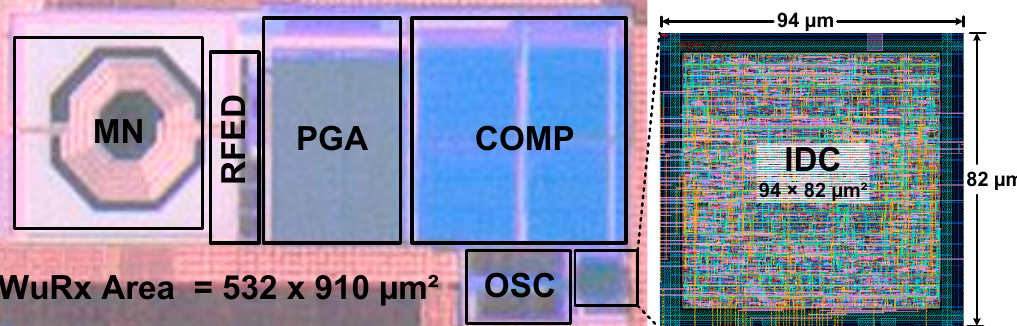
Figure 13. WuRx chip microphotograph and magnified IDC layout.